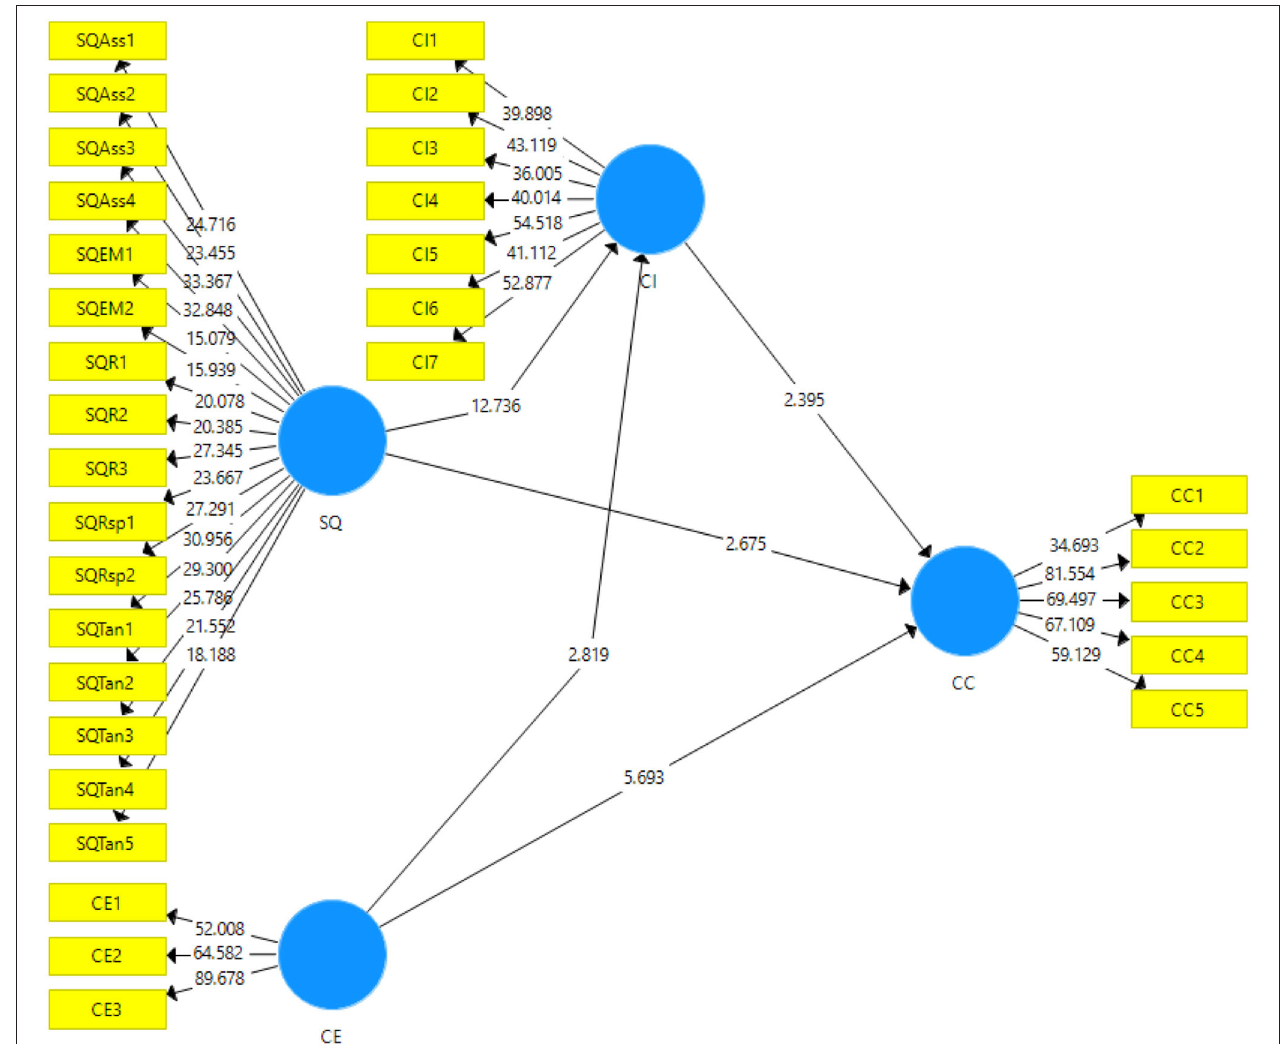
FIGURE 3 | Output of structural model Bootstrapping. SQ, Service quality; CE, Customer experience; CI, Corporate imagel; CC, Customer